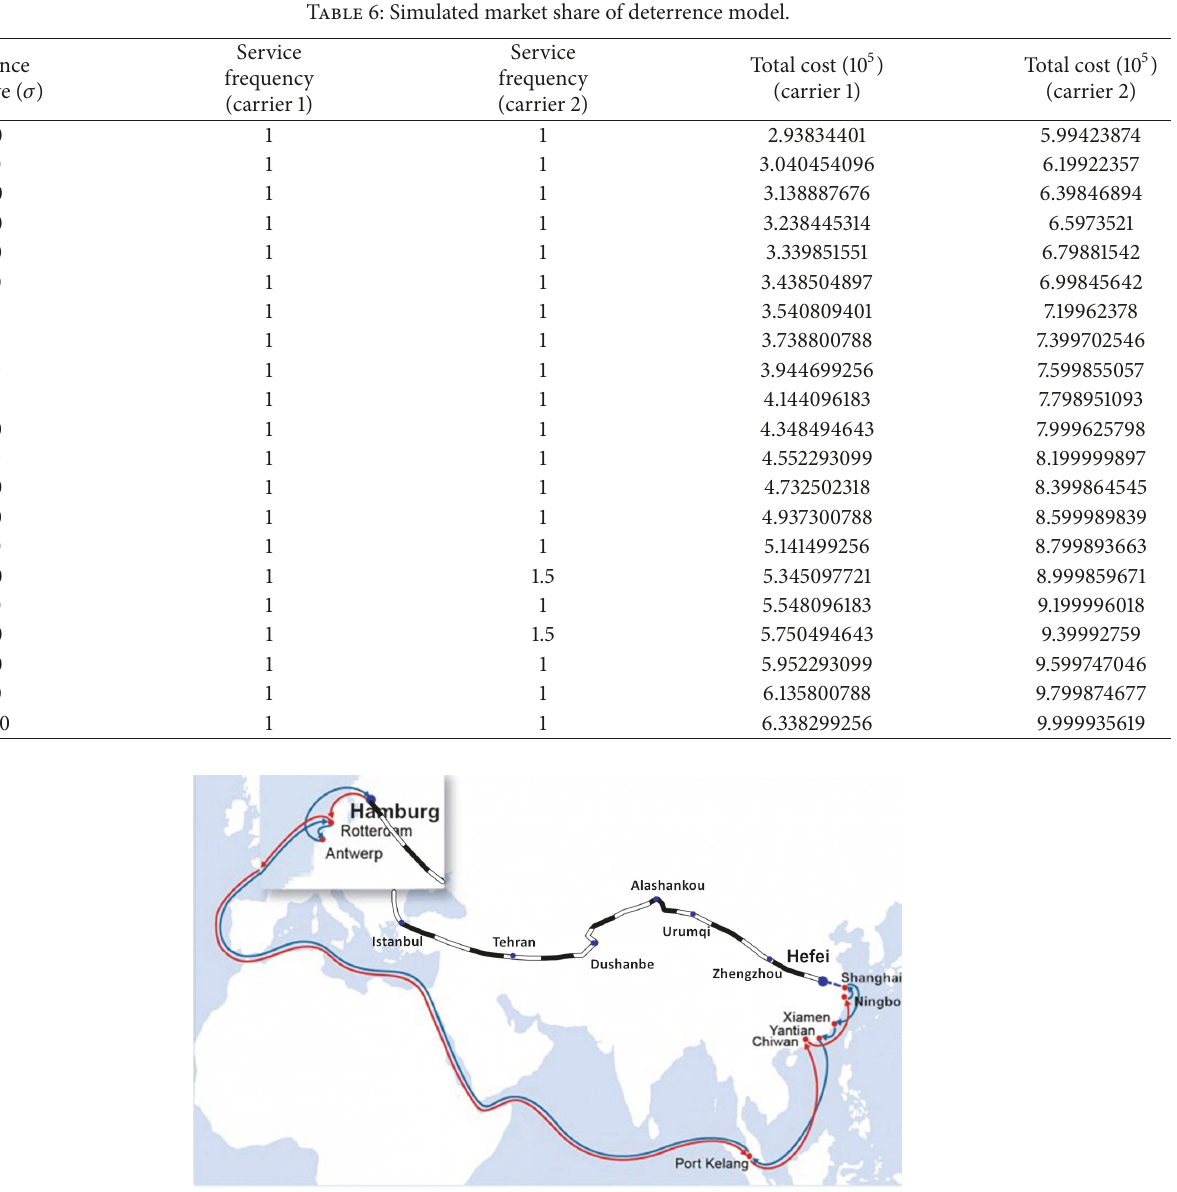
Figure 4: Route from Hefei to Hamburg based on “Asia-Europe Express” in PIL (source: author, adapted from https://www.pilship.com/ and Google